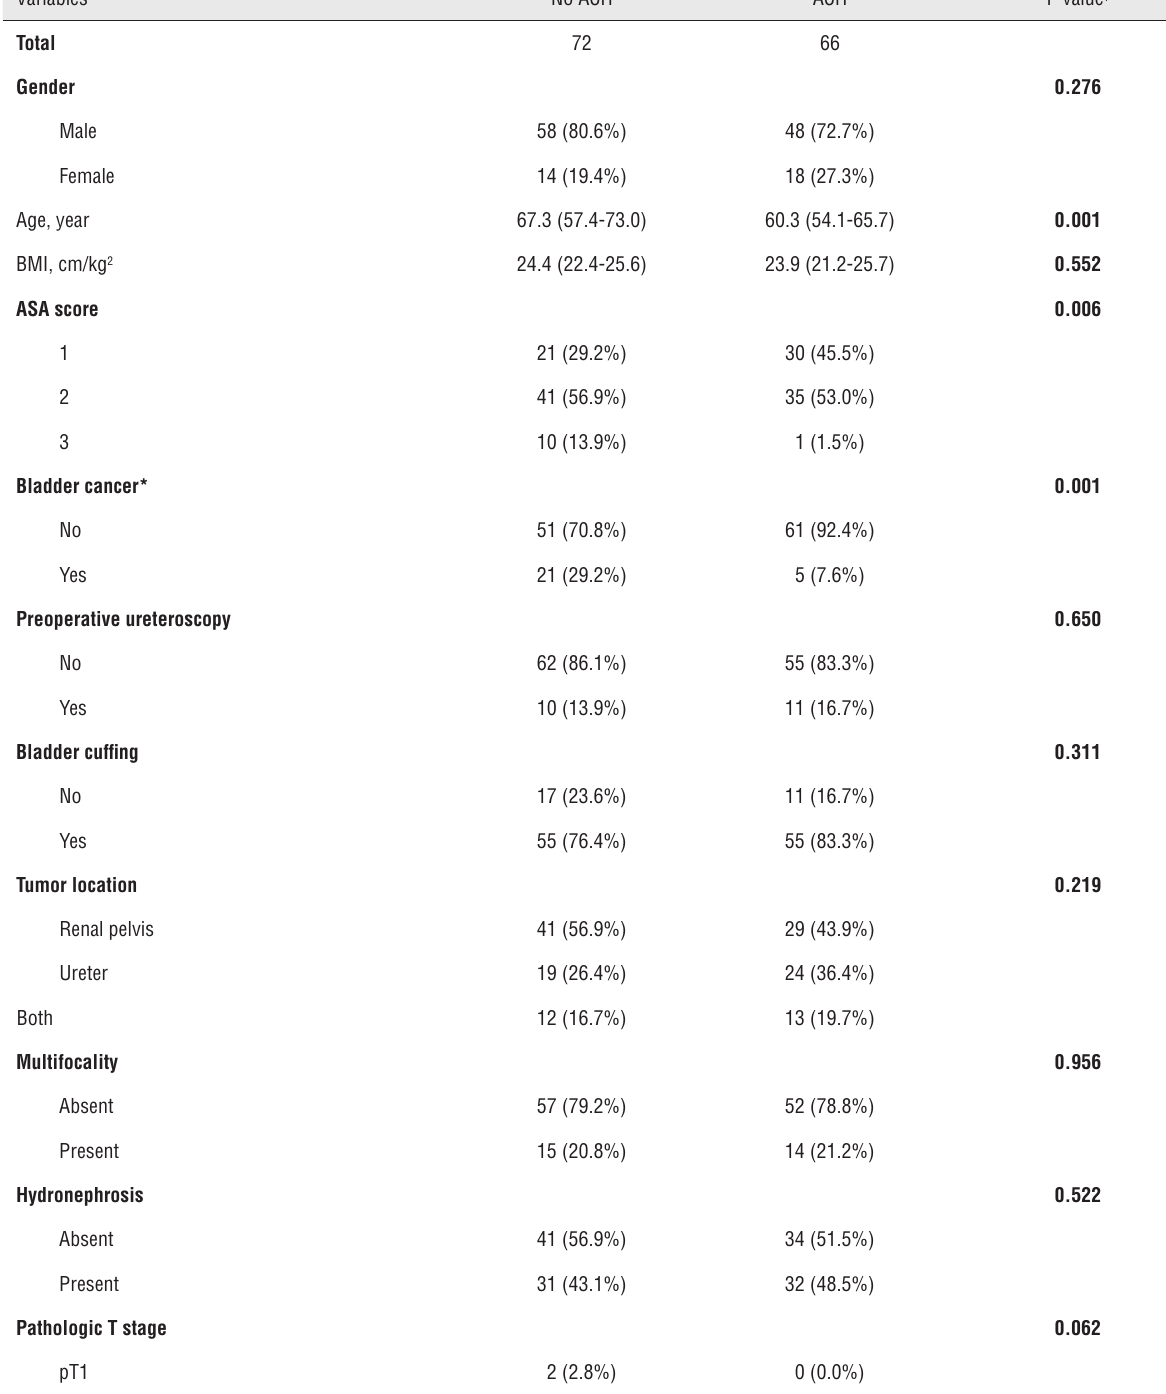
Table 1. patient